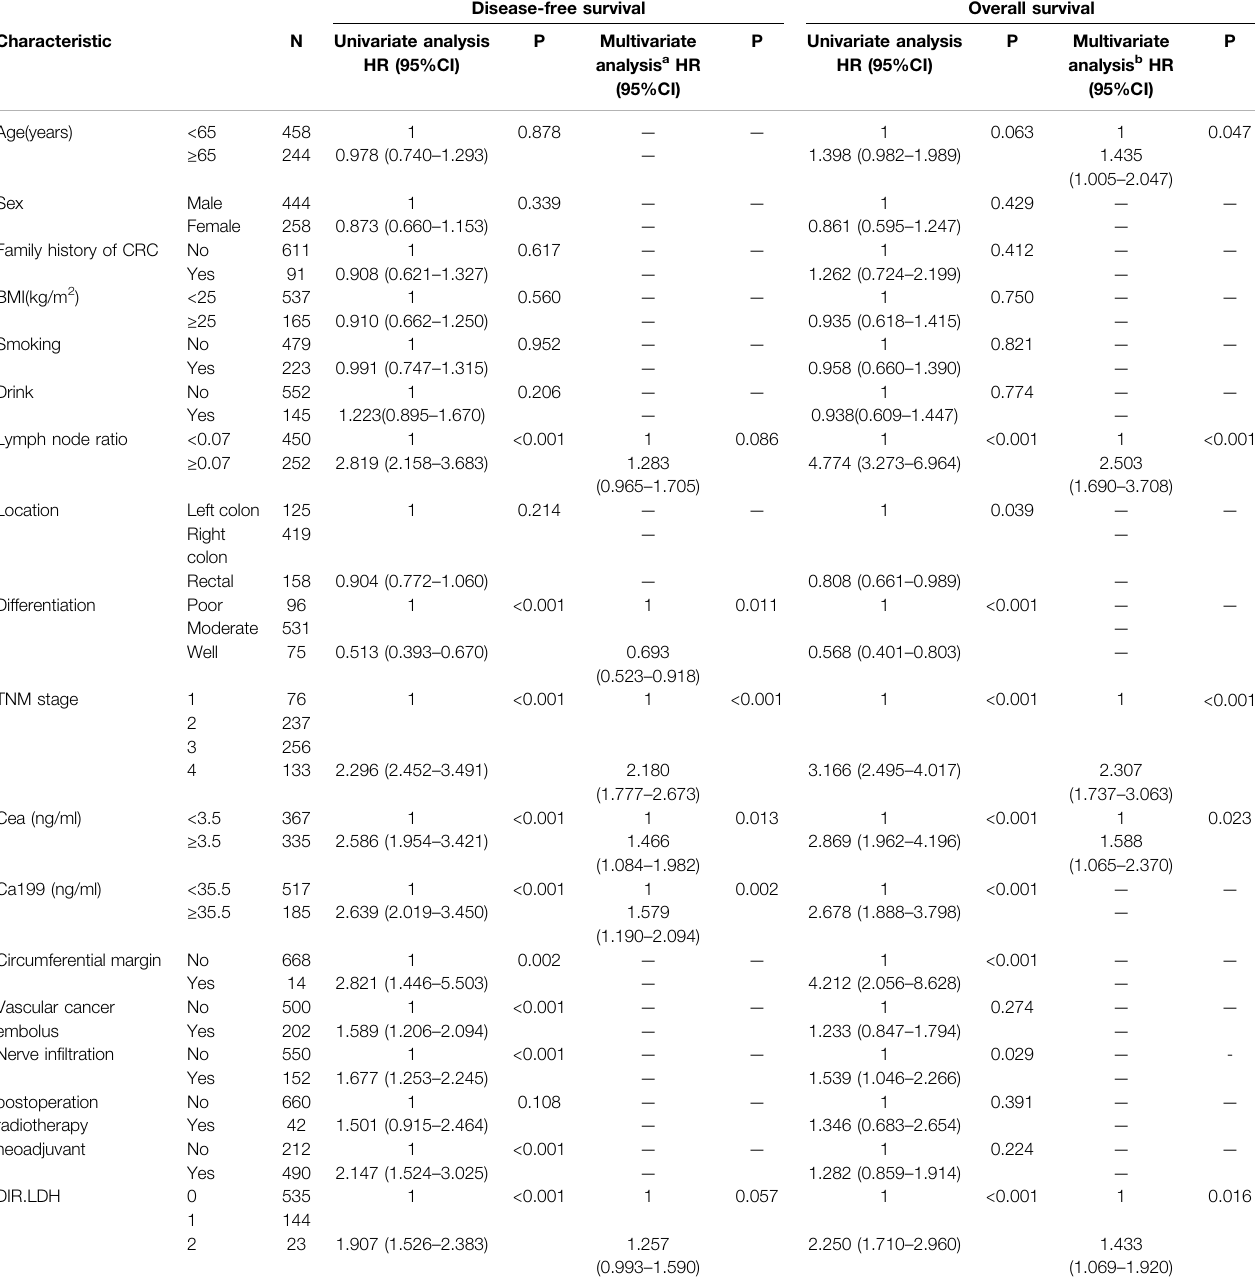
a The multivariate Cox regression model included DIR.LDH, lymph node ratio, differentiation, TNM stage, circumferential margin, vascular cancer embolus, nerve in fi ltration, CEA, CA199 and neoadjuvant. b The multivariate Cox regression model included DIR.LDH, lymph node ratio, location, differentiation, TNM stage, circumferential margin, nerve in fi ltration, CEA, CA199 and age. Abbreviation: CEA: carcinoembryonic antigen; CA199: carbohydrate antigen 19-9; DIR: direct bilirubin/indirect bilirubin; LDH: lactate dehydrogenase; DIR.LDH: the combination of DIR and